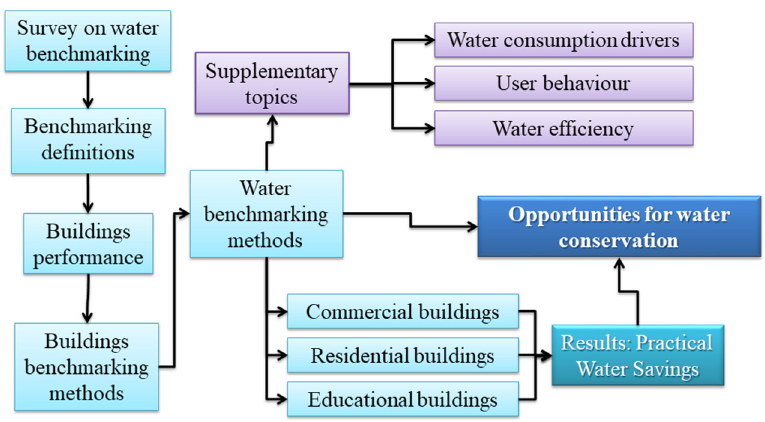
Figure 1. Review framework for the main and supplementary searches.